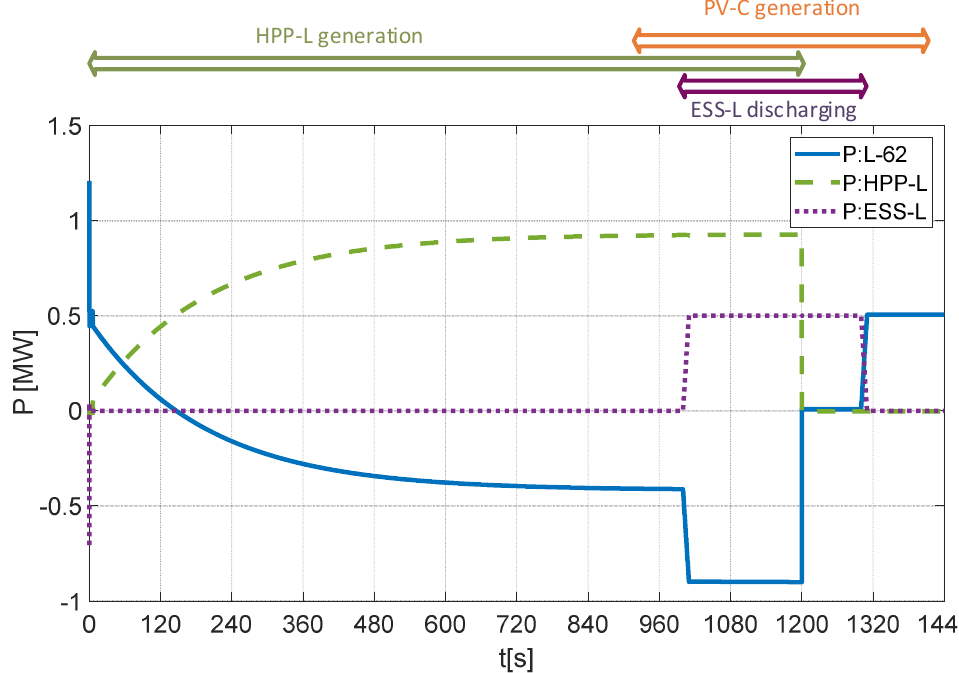
Figure 6. Active power changes P in the distribution line L-62 associated with main station R-J . Changes of generated power of hydropower plant HPP-L . Changes of generated power of battery storage system ESS-L . Analysis carried out during a series of switching operations of HPP-L , PV-C and ESS-L .